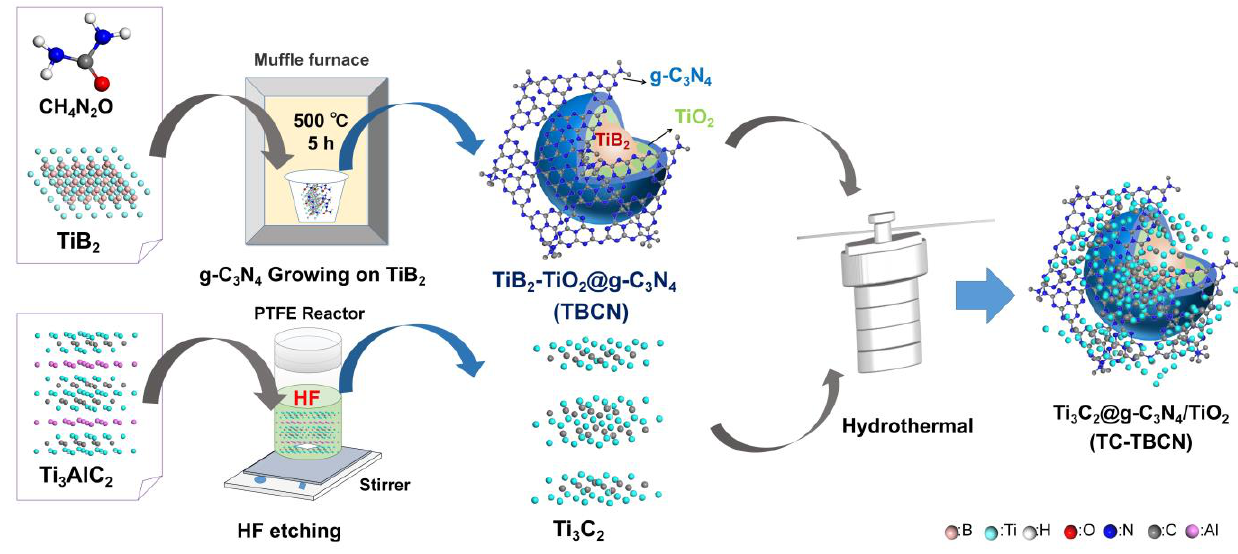
Figure 1. Schematic of the synthesis process for TC-TBCN composite.